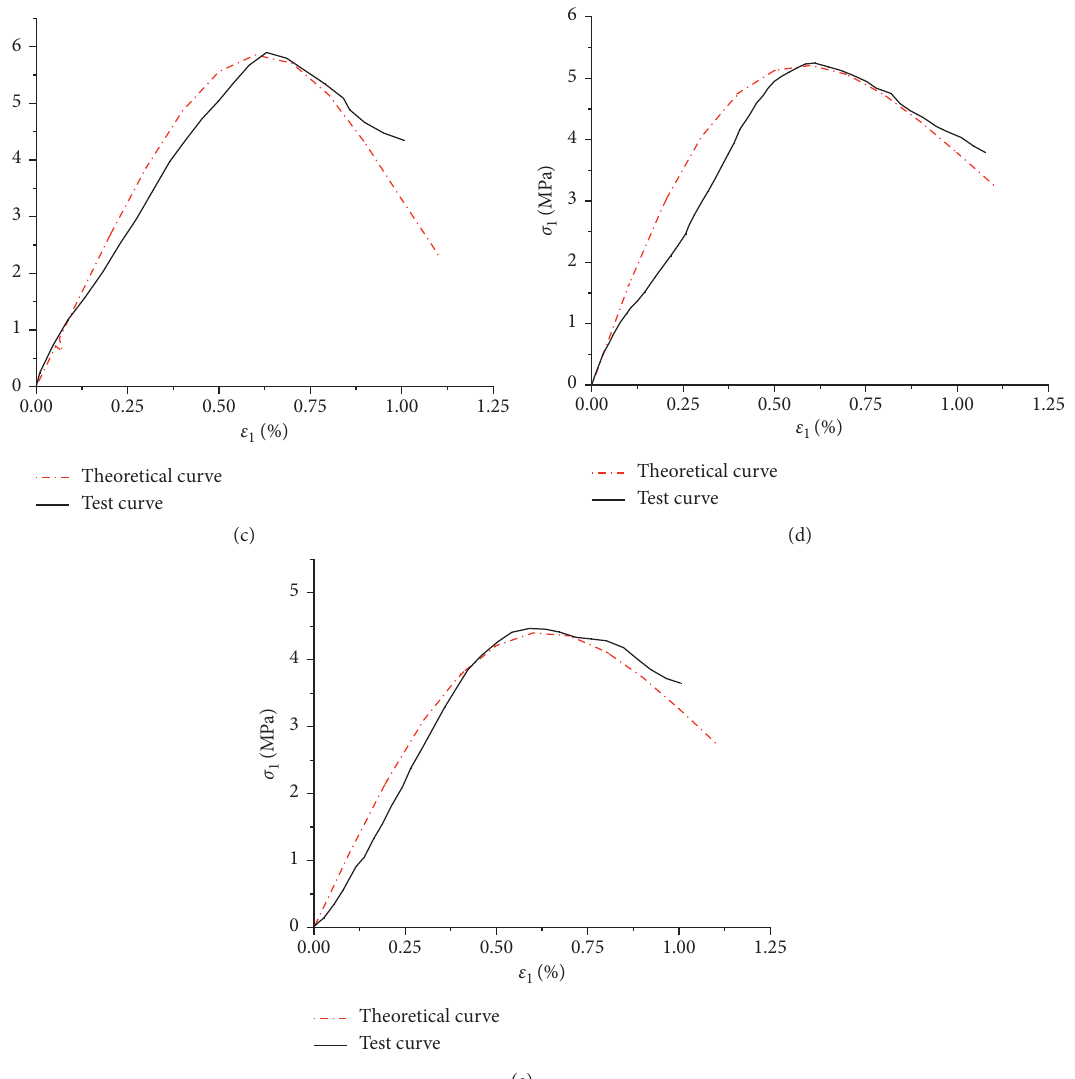
Figure 4: Calculated values of damage evolution model contrast with experimental values. (a) p � 0MPa. (b) p � 0 . 3MPa. (c) p � 0 . 6MPa. (d) p � 0 . 9MPa. (e) p � 1 .